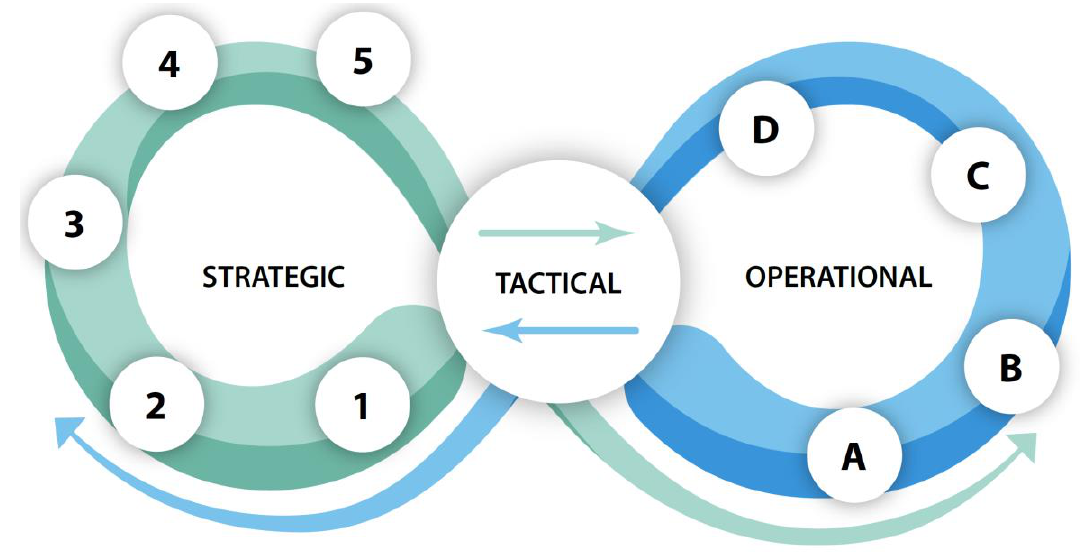
Figure 1. FAIR framework, linking strategic and operational asset management through a tactical